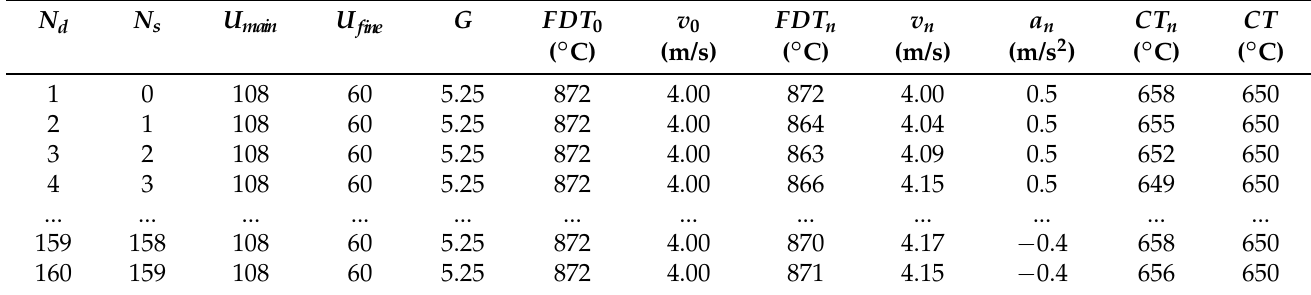
Table 2. Input and output data of modeling with same specifications for